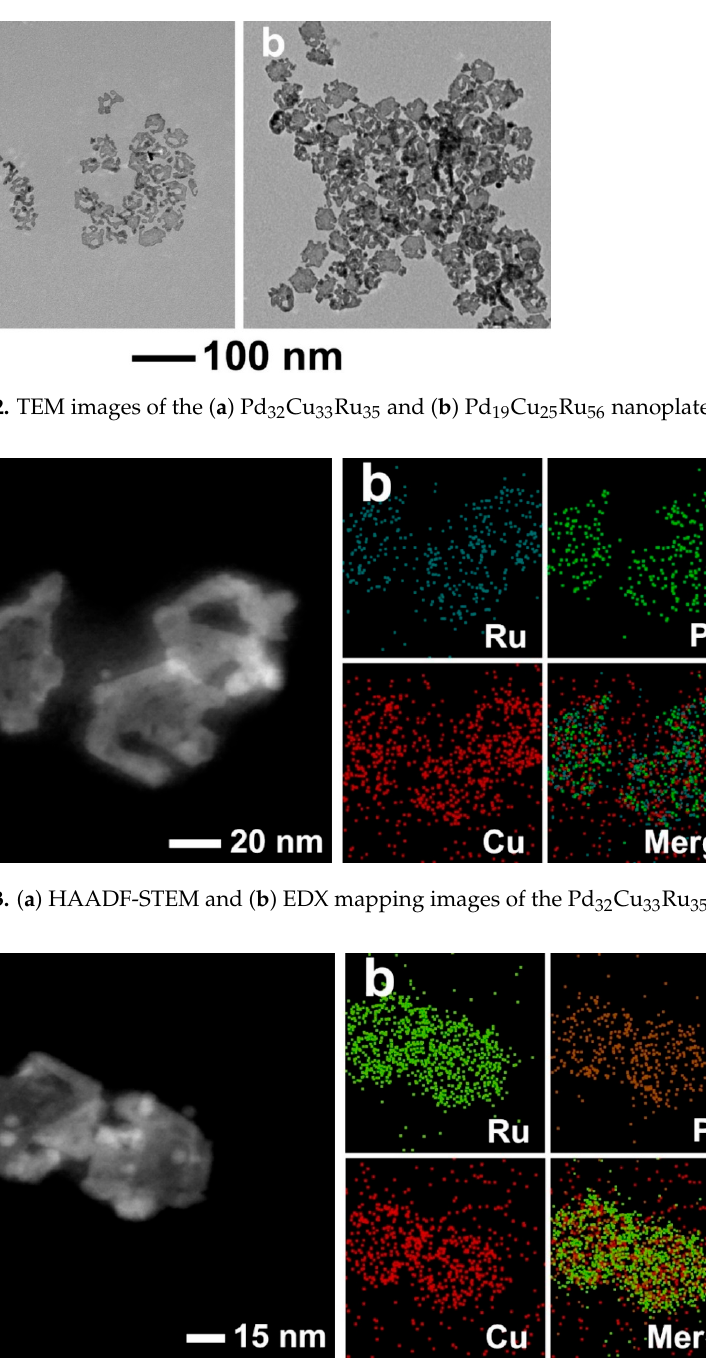
Figure 1. ( a ) TEM, ( b ) HAADF-STEM ( c ) HRTEM and ( d ) HAADF-STEM-EDX mapping images of a planar Pd 24 Cu 29 Ru 47 nanoplate. ( e ) HAADF-STEM-EDX images of a vertically upstanding Pd 24 Cu 29 Ru 47 nanoplate. Pd (orange), Ru (red), and Cu (green). ( f ) Line-scan profiles along the side